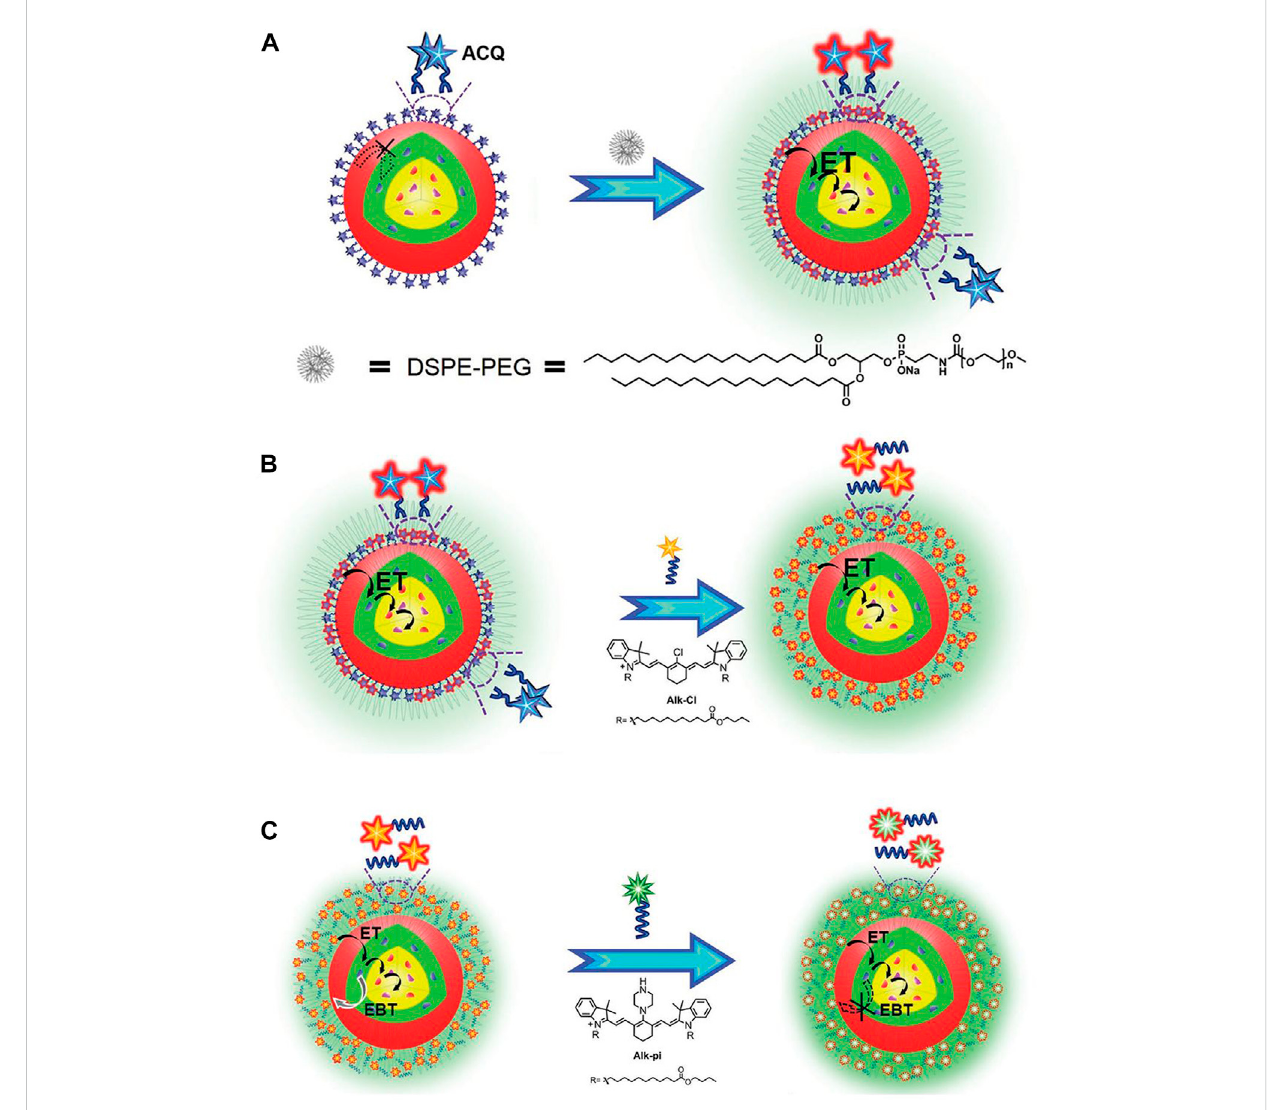
FIGURE 4 (A) Schematic illustration of the alleviation of Aggregation-Caused Quenching (ACQ) and promotion of dye sensitization in aqueous phase by coatingwithDSPE-PEG. (B) Schematicillustrationofimprovingdye-sensitizationperformancethrougheliminatingACQofdyemolecules. (C) Schematic illustration of improving dye sensitization performance through alleviating EBT from Nd 3+ to dyes. [Reprinted with permission from Ref. (Liang et